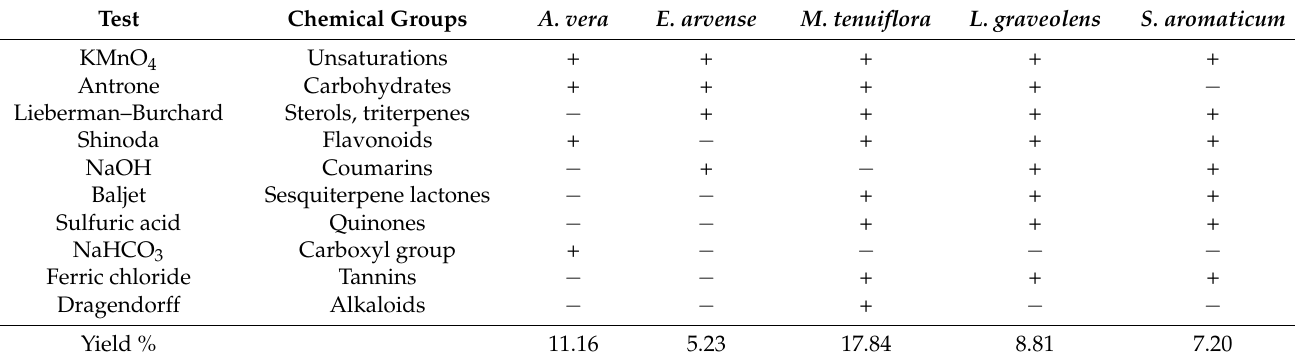
Table 2. Phytochemical